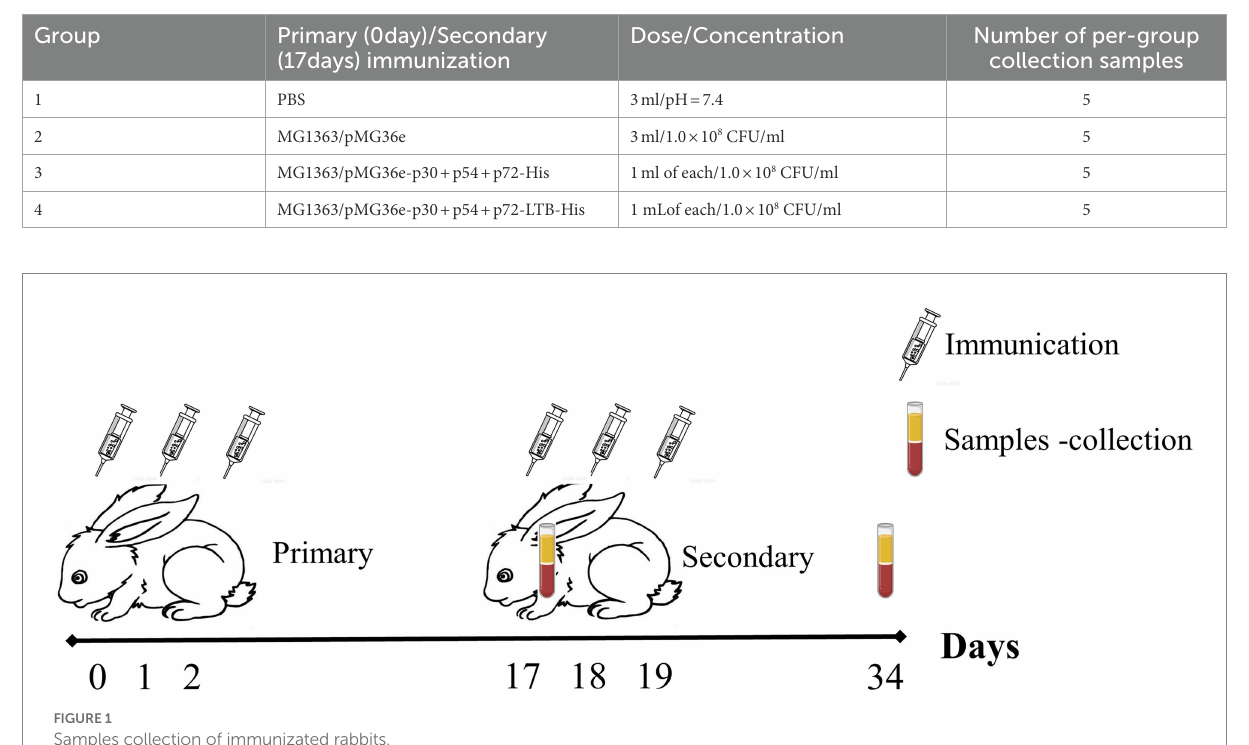
TABLE 1 Immunization details for rabbits.